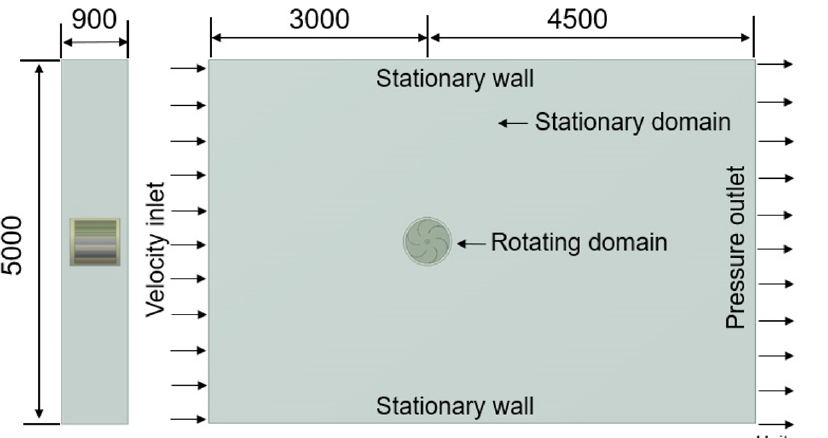
Figure 8. Dimensions of the flow